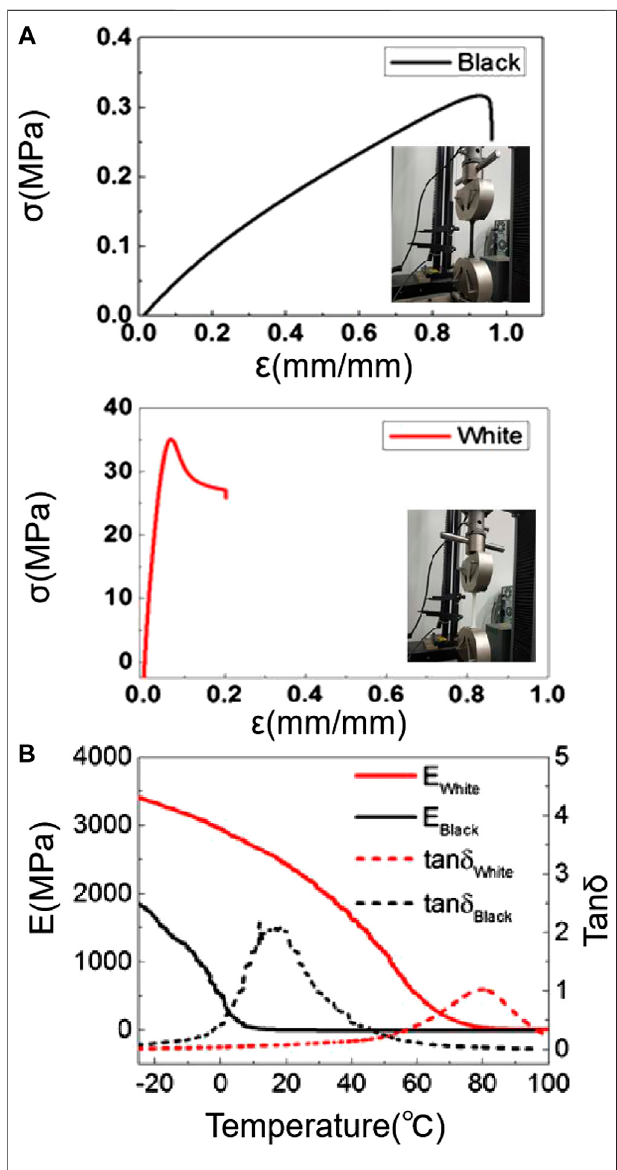
FIGURE 2 | Basic mechanical test results of 3D printed materials VeroWhitePlus and TangoBlackPlus. (A) The uniaxial stretching mechanical and (B) the dynamic mechanical analysis testing results of the two